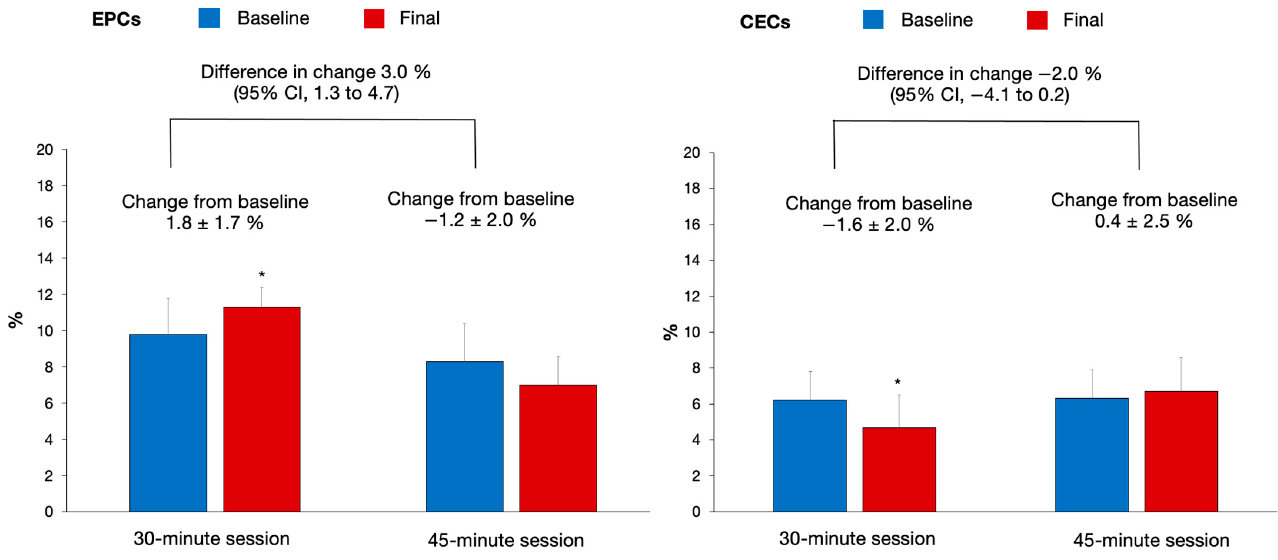
Figure 1. Effects of an acute session of exercise of different durations in the circulating levels of endothelial progenitor cells (EPCs) and endothelial cells (CECs). Data are presented as the number of circulating cells (%) × 10 − 3 . * Significant difference from baseline, p < 0.05